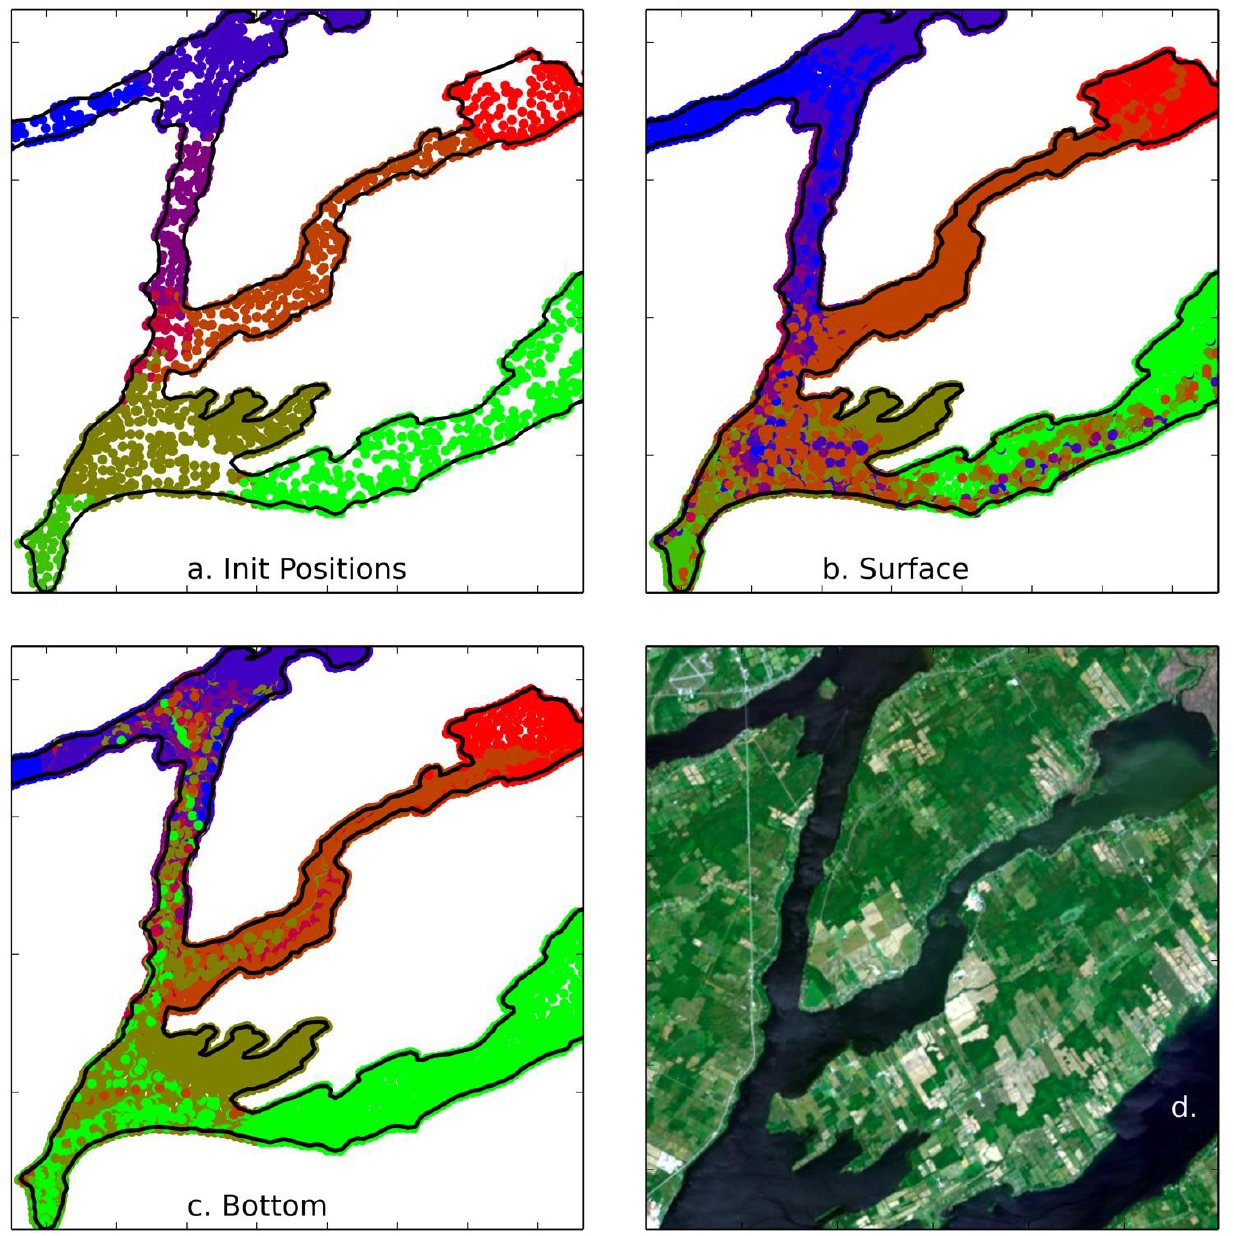
Figure 6. Simulated particle movement from May to June 2018: ( a ) initial particle positions and designated colours, maps of overlayed particle positions for ( b ) surface particles and ( c ) bottom particles, at the end of June 2018. ( d ) Landsat satellite image of Hay Bay on 29 June 2018 (https://livingatlas2.arcgis.com/landsatexplorer/ (accessed on 19 April 2020)) (Agricultural Color Image Setting).